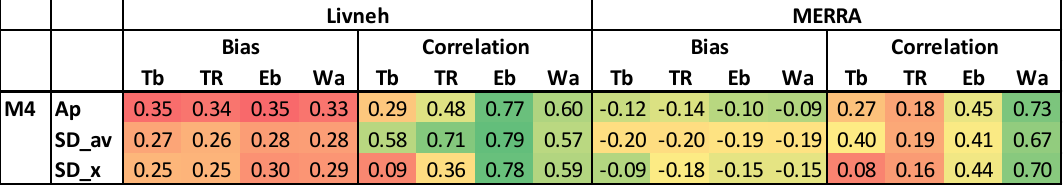
Figure 8. Performance of snowmelt models (median of catchments) with soil and snow parameters estimated without using discharge data. Results for catchments with more than 40% of precipitation falling as snow. The cells were color-coded using a green (good performance)—yellow—red (bad performance) scale. The rows show the results using three approaches for estimating the snow parameters Ap (a priori); SD_av (using SNODAS data and the daily average temperature); SD_x (using SNODAS data and the daily maximum